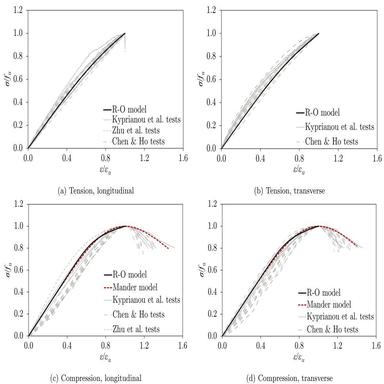
Comparison of the proposed model for OSB with the obtained normalised test curves in both directions in (a–b) tension and (c–d) compression.